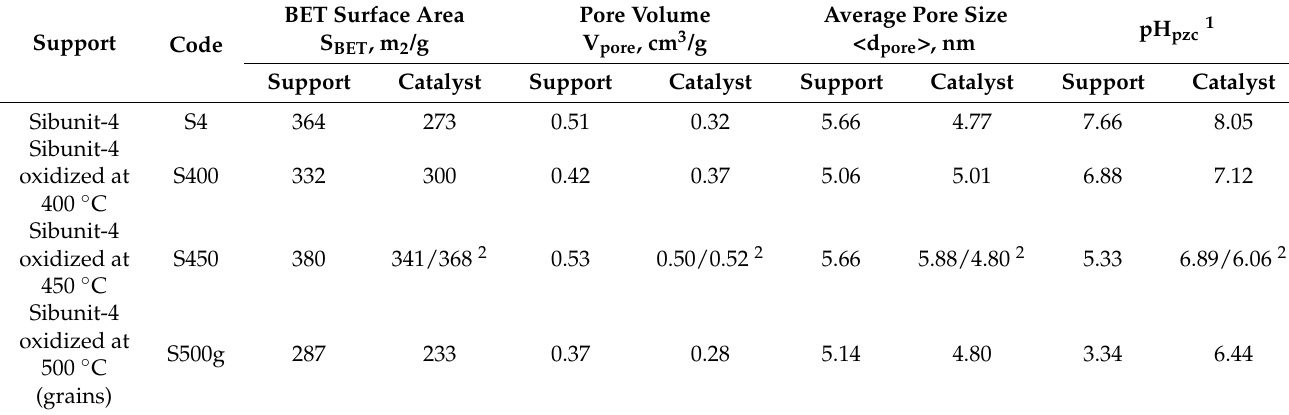
Table 1. Texture and acid characteristics of carbon support and the supported ruthenium catalysts (3 wt % of Ru).